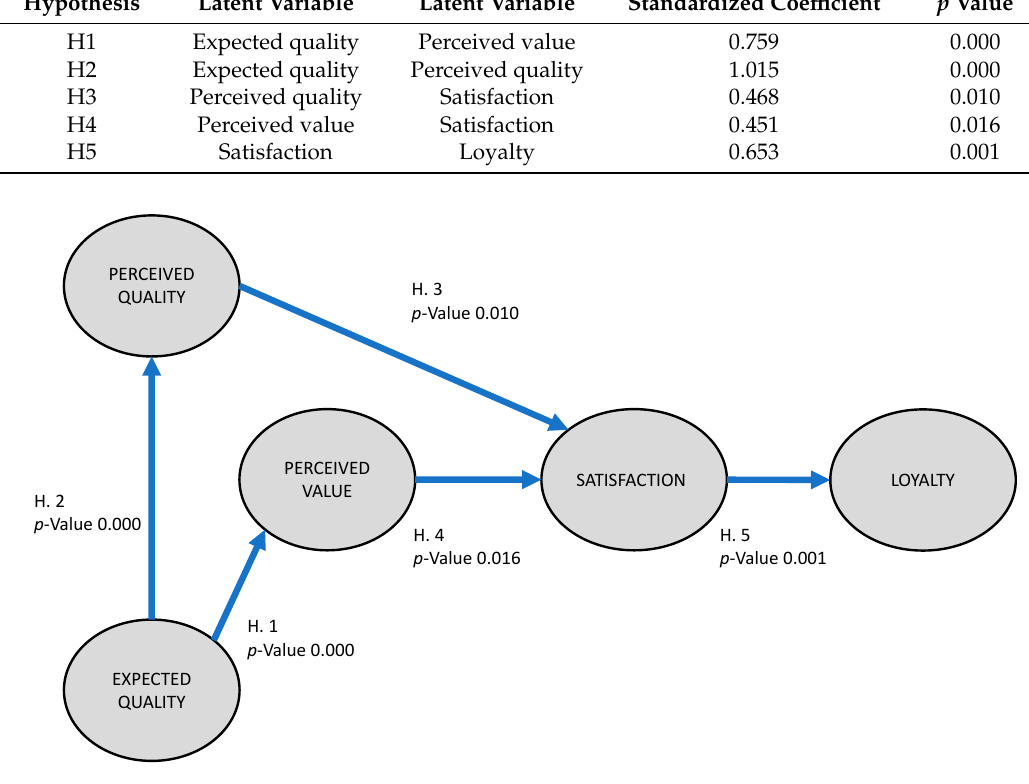
Figure 3. Path diagram of the proposed model with the p value.